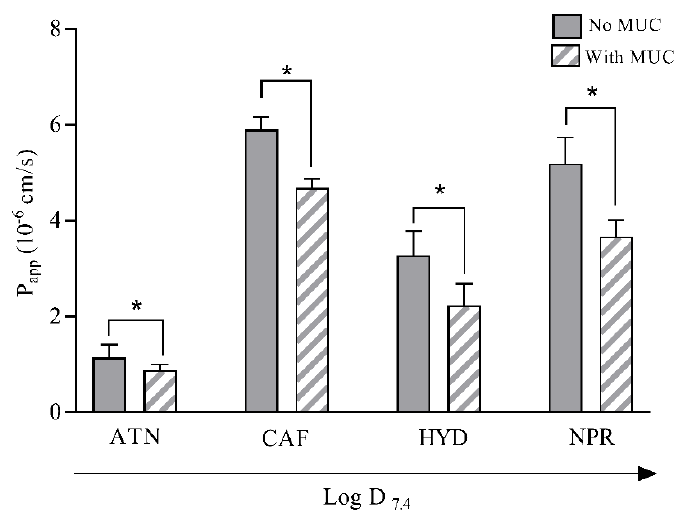
Figure 5. Apparent permeability (P app ) of CAF, ATN, NPR, and HYD with and without mucin 1.0%. The results are shown as mean ± SD ( n = 18). * Significant difference ( p < 0.05) between the presence and absence of mucin (MUC 1.0%).